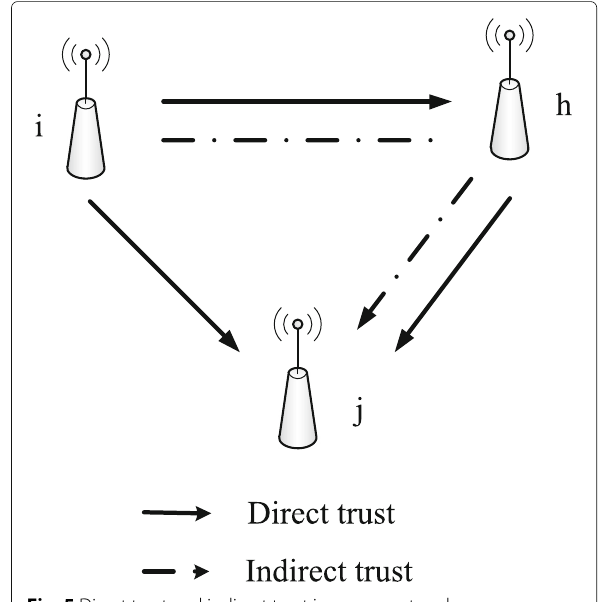
Fig. 5 Direct trust and indirect trust in sensor networks (cid:6) (cid:6) where α and β are the combined trust parameters about i i node i respectively.